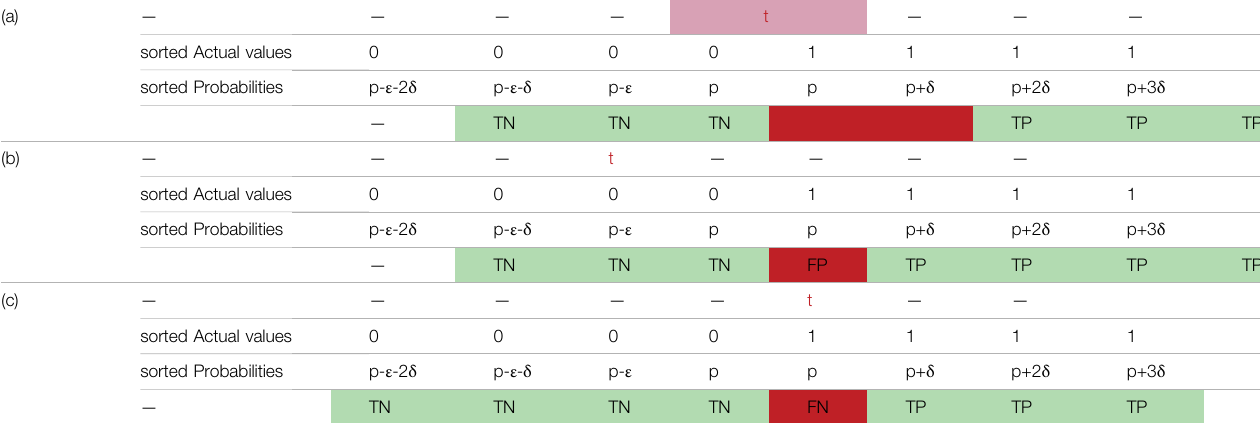
TABLE 10 | A group of realizations with N (cid:1) 8, AN (cid:1) 4, AP (cid:1) 4, and 0 < AUC < 1. (a)